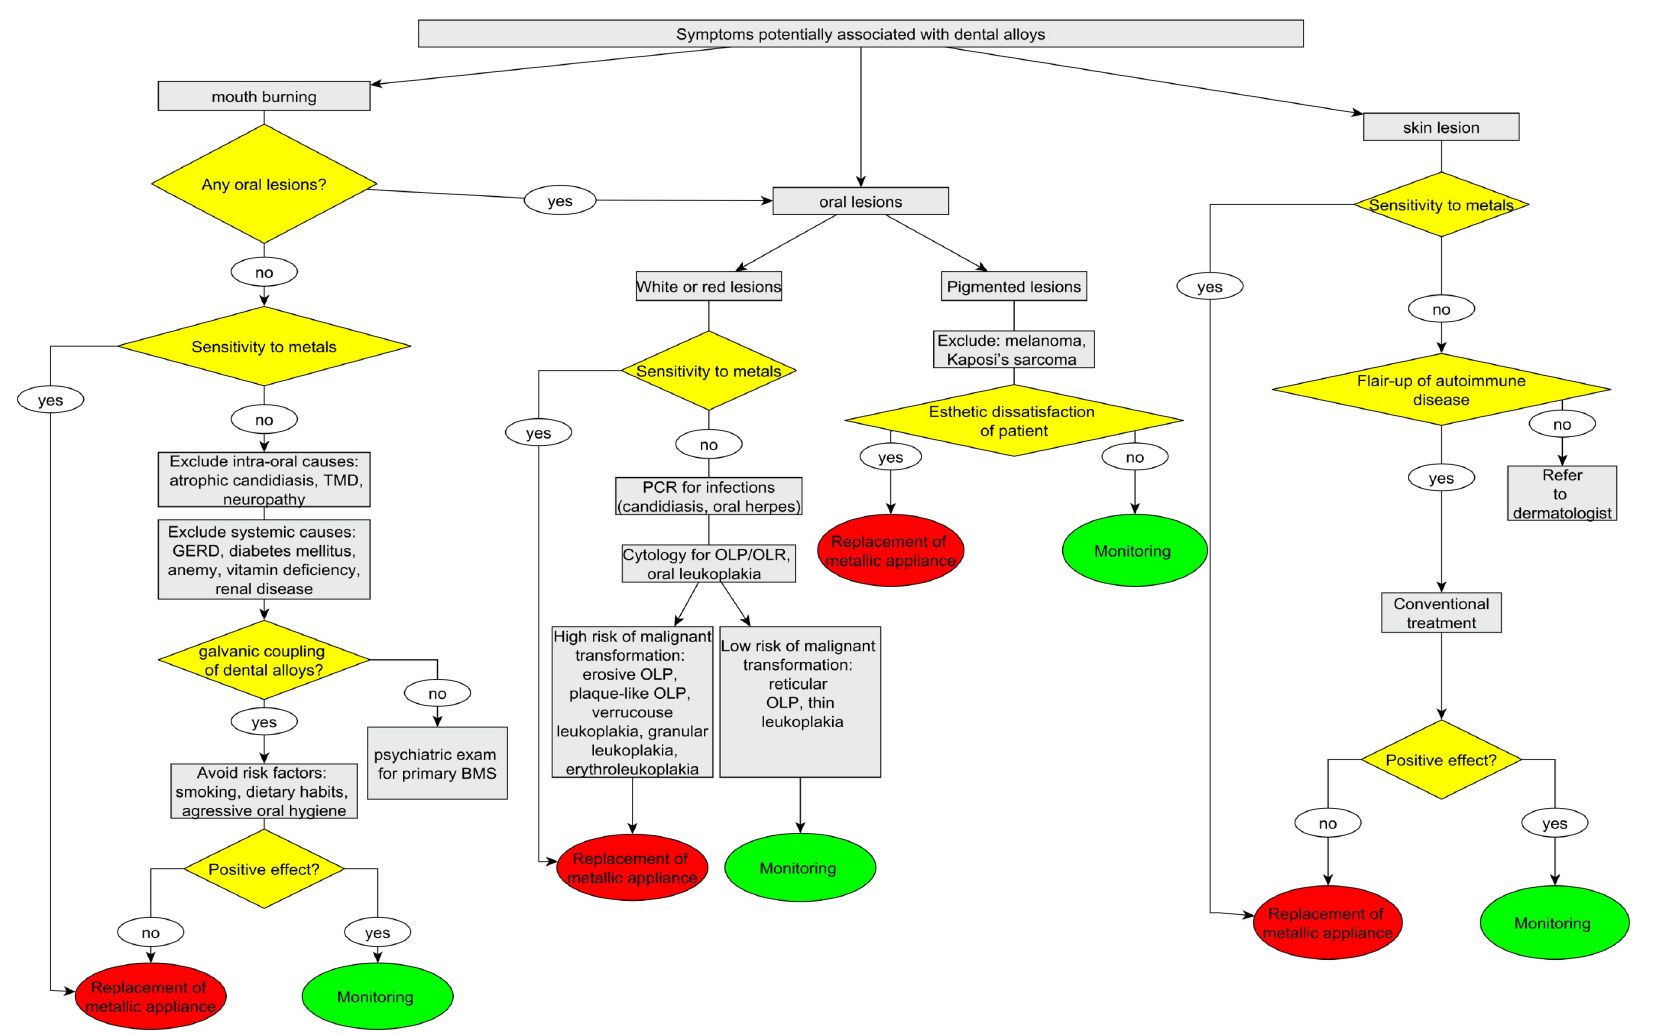
Figure 4. Decision tree for diagnosis and management of conditions potentially associated with dental alloys.